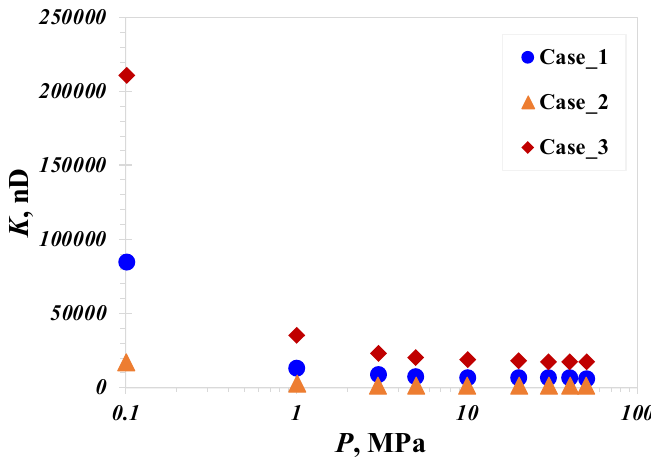
Figure 7. Impact of PSD on apparent gas permeability versus pressure.